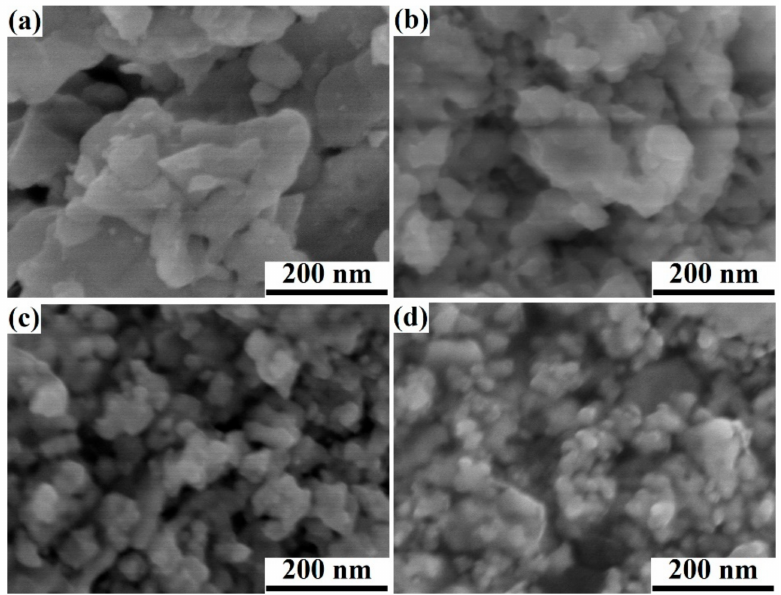
Figure 3. SEM micrographs of fracture surfaces of Bi 1 − x La x Fe 0.95 Co 0.05 O 3 : ( a ) x = 0.05; ( b ) x = 0.10; ( c ) x = 0.15; ( d ) x =